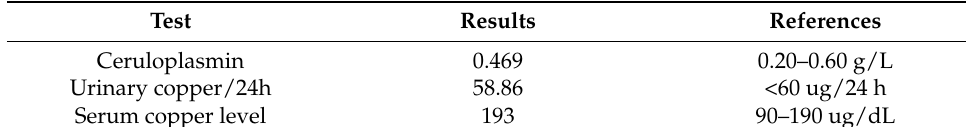
Table 1. Copper metabolism test results.